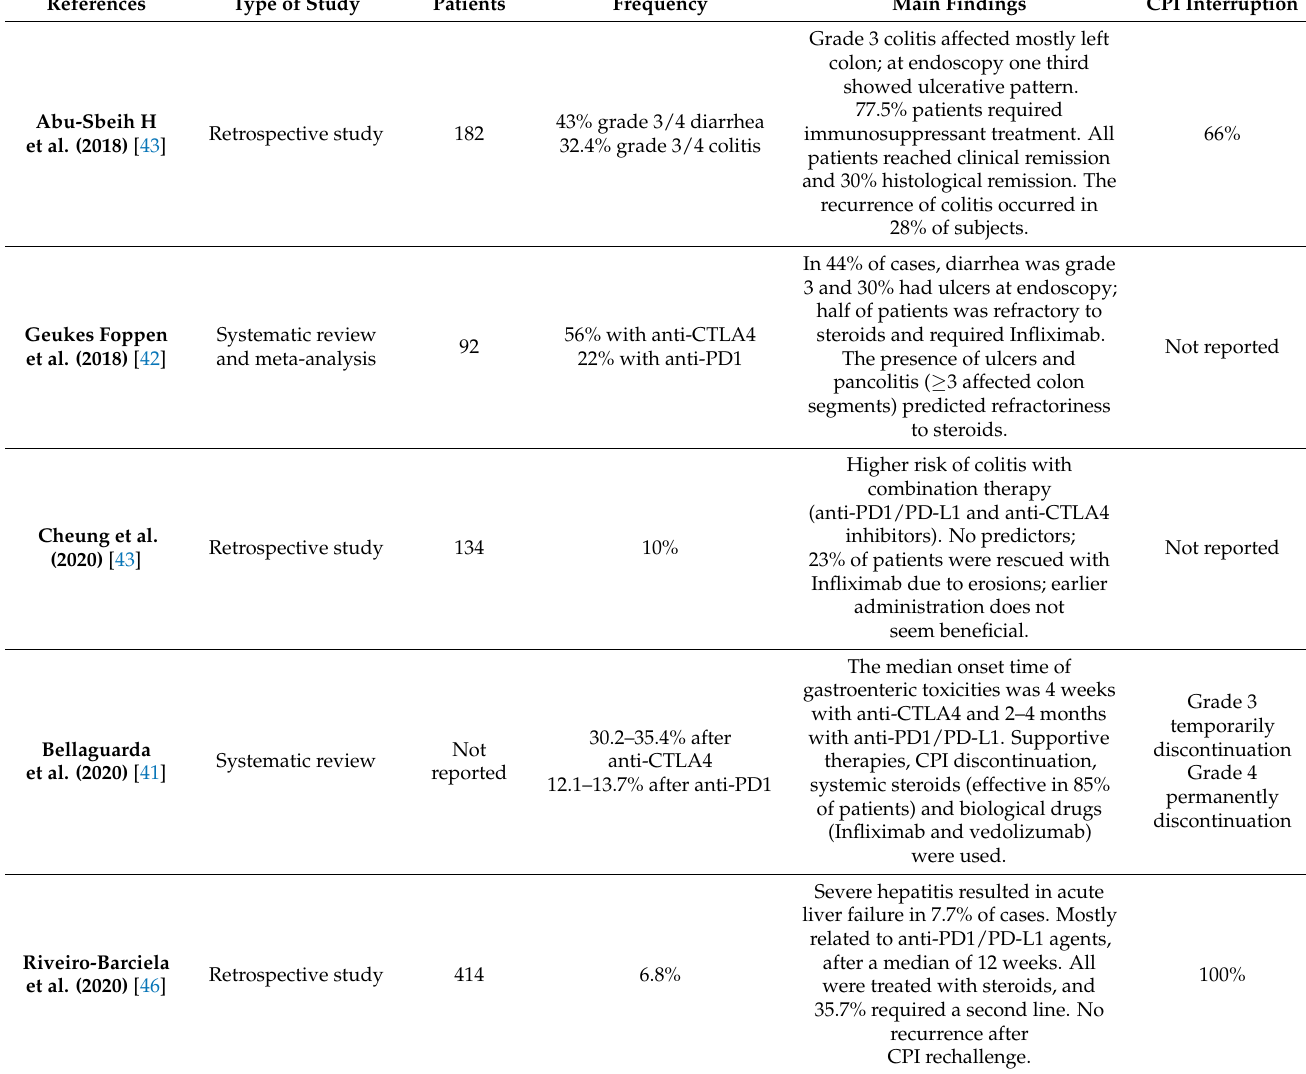
Table 4. Gastroenteric toxicities after checkpoint inhibitors